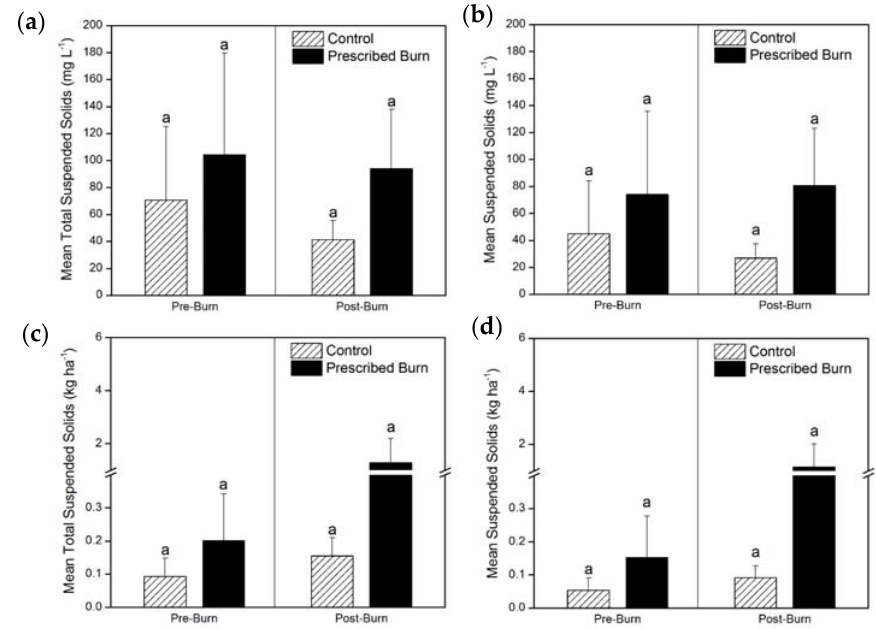
Figure 9. Comparisons of mean ±95% confidence interval (CI) pre ‐ burn and post ‐ burn ( a ) total suspended solids concentration; ( b ) sediments concentration; ( c ) total suspended solids loads; and ( d ) sediment loads data by treatments combined over watersheds. Significant differences ( p values < 0.05) are noted by different letters at the top of each bar.